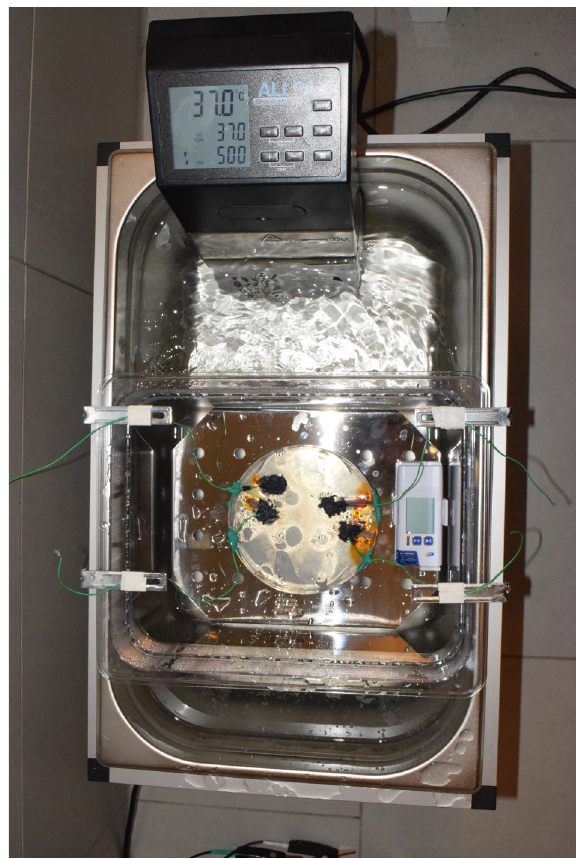
Figure 4. The climate chamber setup. The outer water basin is hold on a constant temperature. The inner basin is filled with water underneath a perforated metal-plate. A petri dish with the PEDOT polymer electrodes is placed above the metal plate. A short piece of pipe cleaner was inserted inside the agarose for better adhesion of the electrode (the pipe cleaners inner wire leads to orange corrosion spots on the agarose). Recording wire endings are outside the chamber (green leads). The data logger is in direct vicinity to the petri